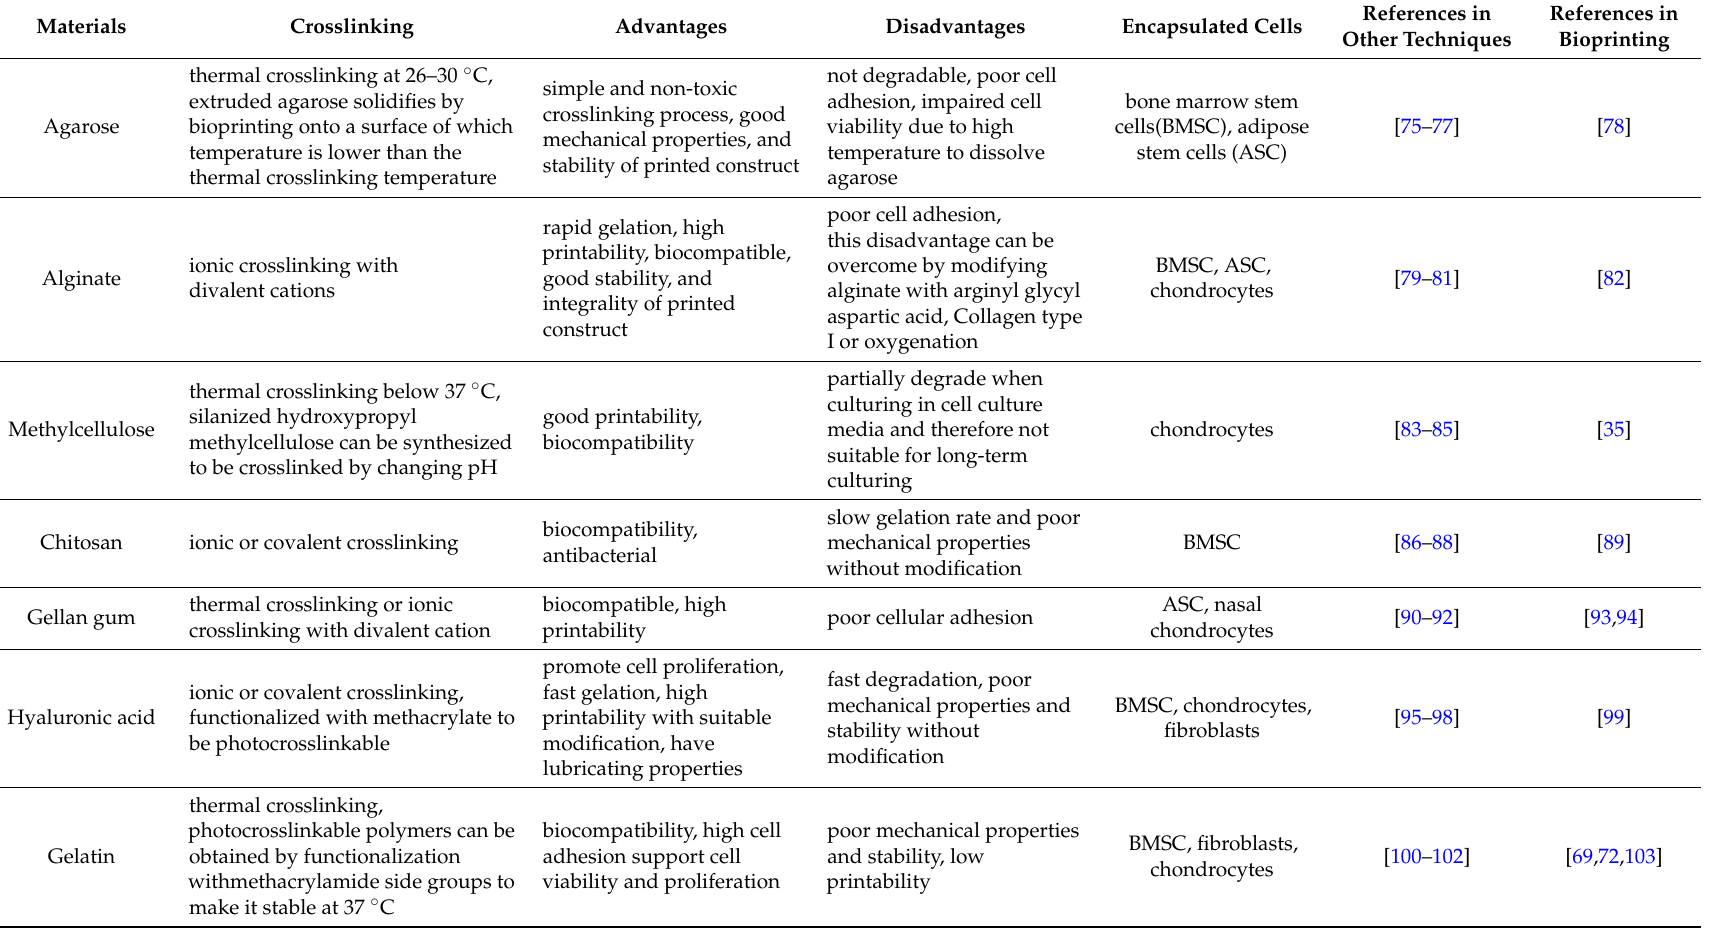
Table 2. Toolkit of bio-ink